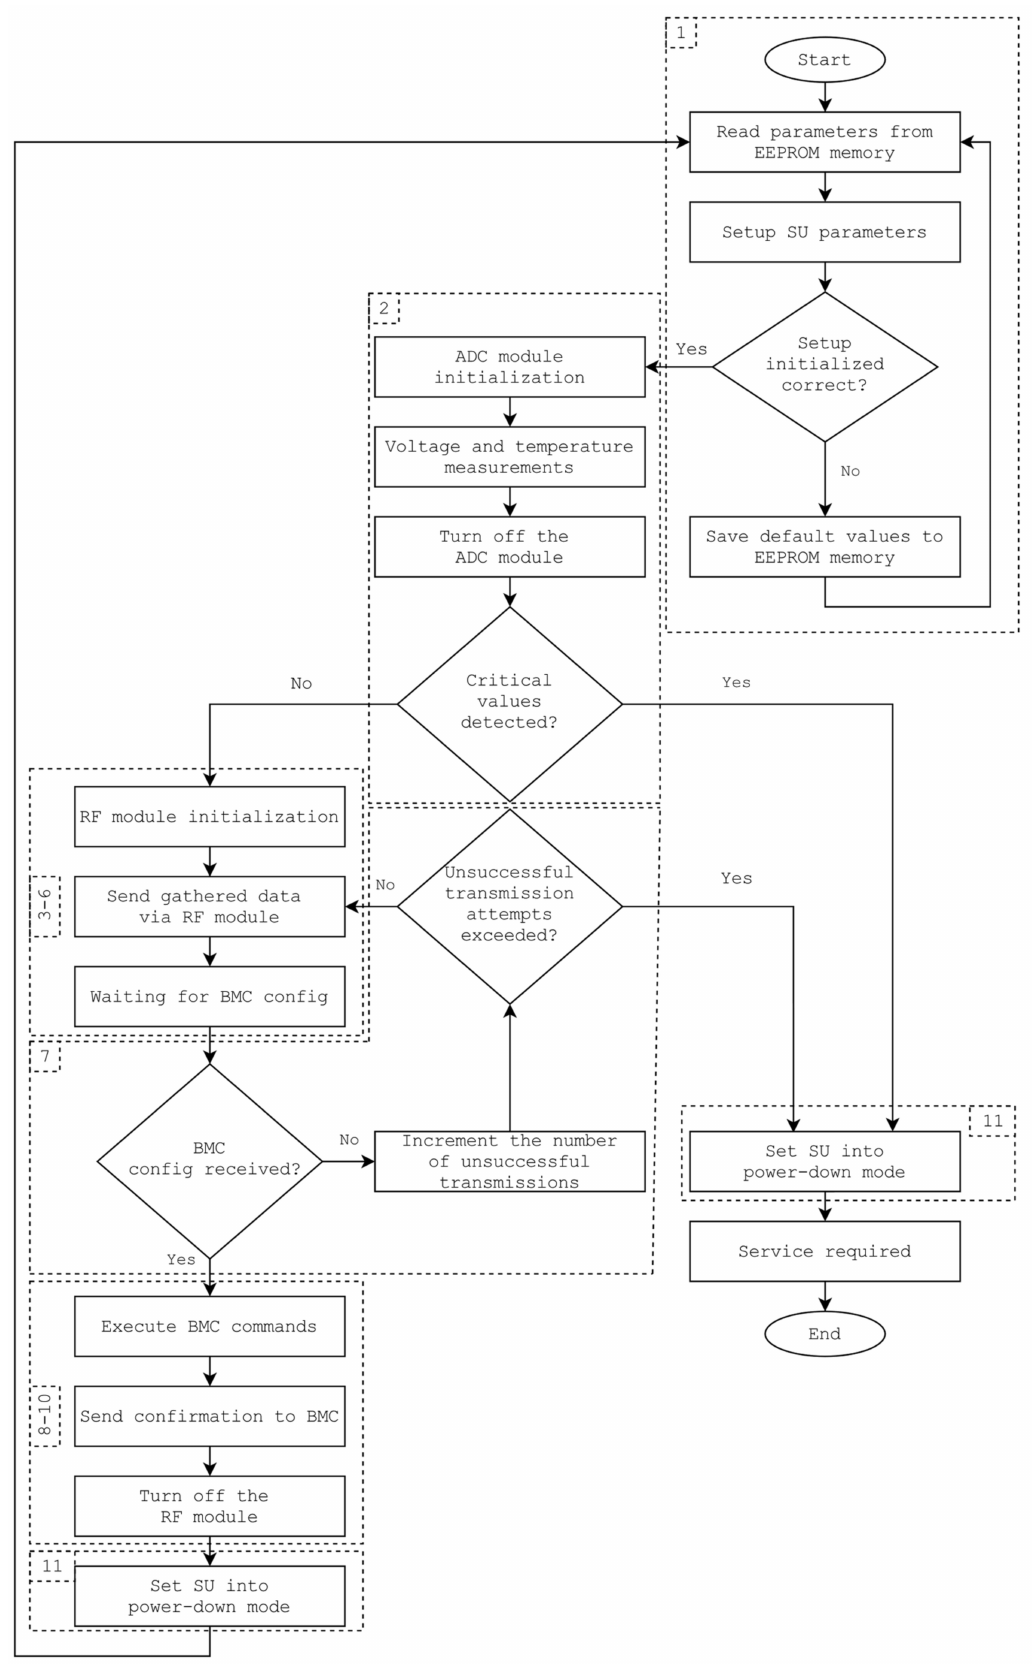
Figure 9. Algorithm illustrating the reporting process executed by all Slave